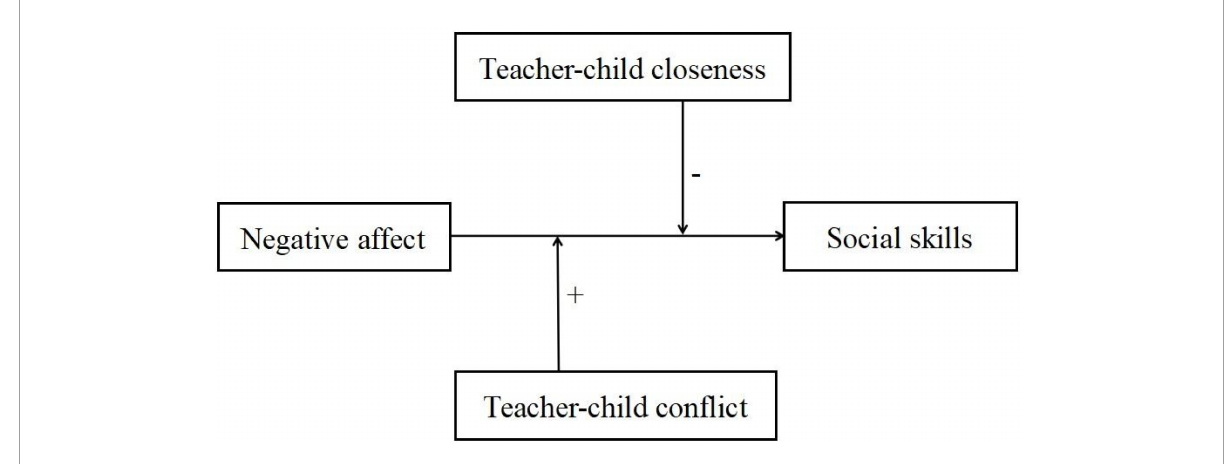
FIGURE1 The proposed moderating